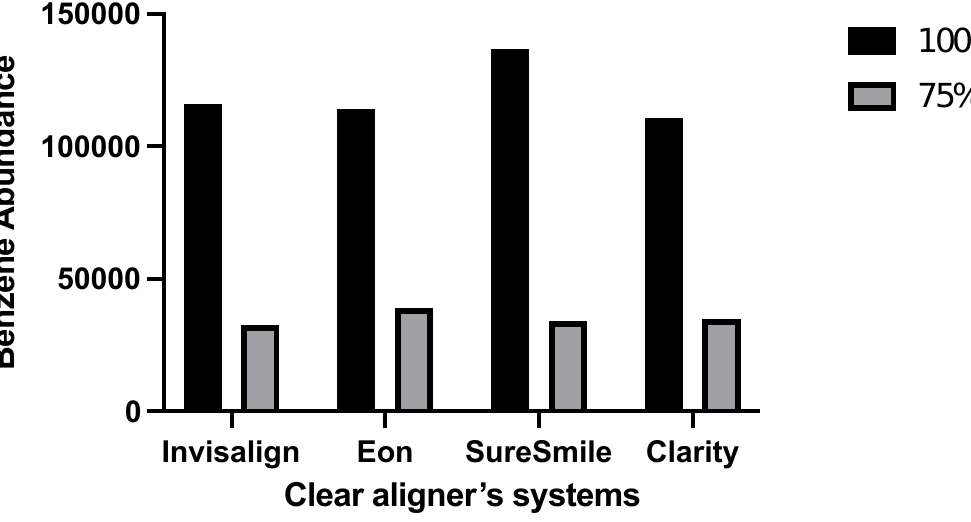
Figure 1. Number of leached chemicals among different systems at different concentrations. Benzene1,3-bis(1,1-dimethylethyl) was the only compound detected in all four systems at the levels of 100% and 75% ethanol. The 50% ethanol presented Phenol, 3,5-bis(1,1- dimethylethyl), in the SureSmile ® and Clarity ® systems with high percentages of 95% and 94%, respectively (Table 1). The abundance of leached benzene was detected at higher levels, at 100% ethanol compared to 75%, with all systems reporting similar amounts. SureSmile ® was the highest system with regard to benzene abundance at 100%, while Eon ® was the highest at 75% (Figure 2).